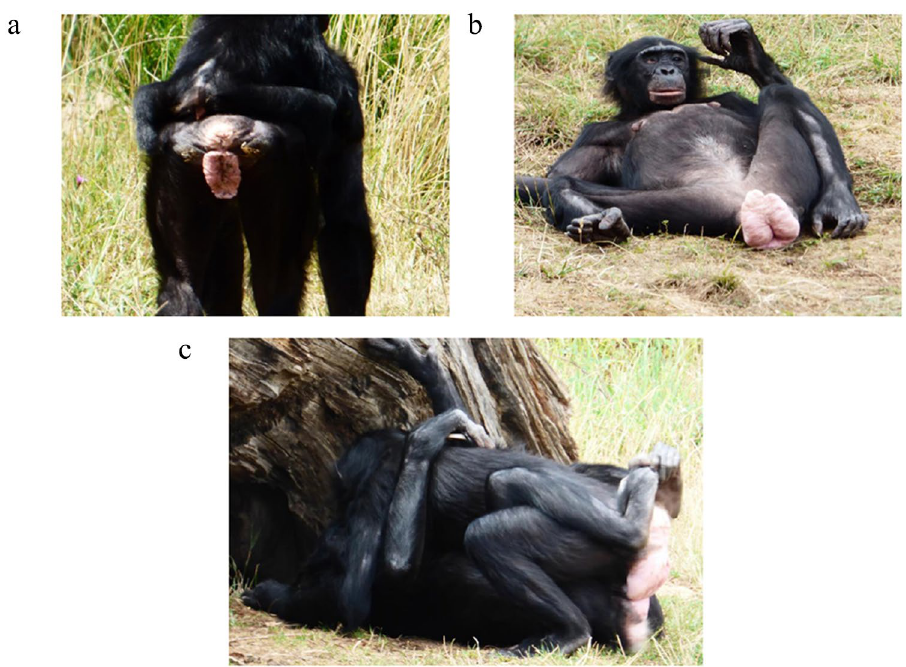
Figure 1. Figure showing: ( a ) minimum swelling phase; ( b ) maximum swelling phase; ( c ) genito-genital rubbing (GGR) between two females in maximum